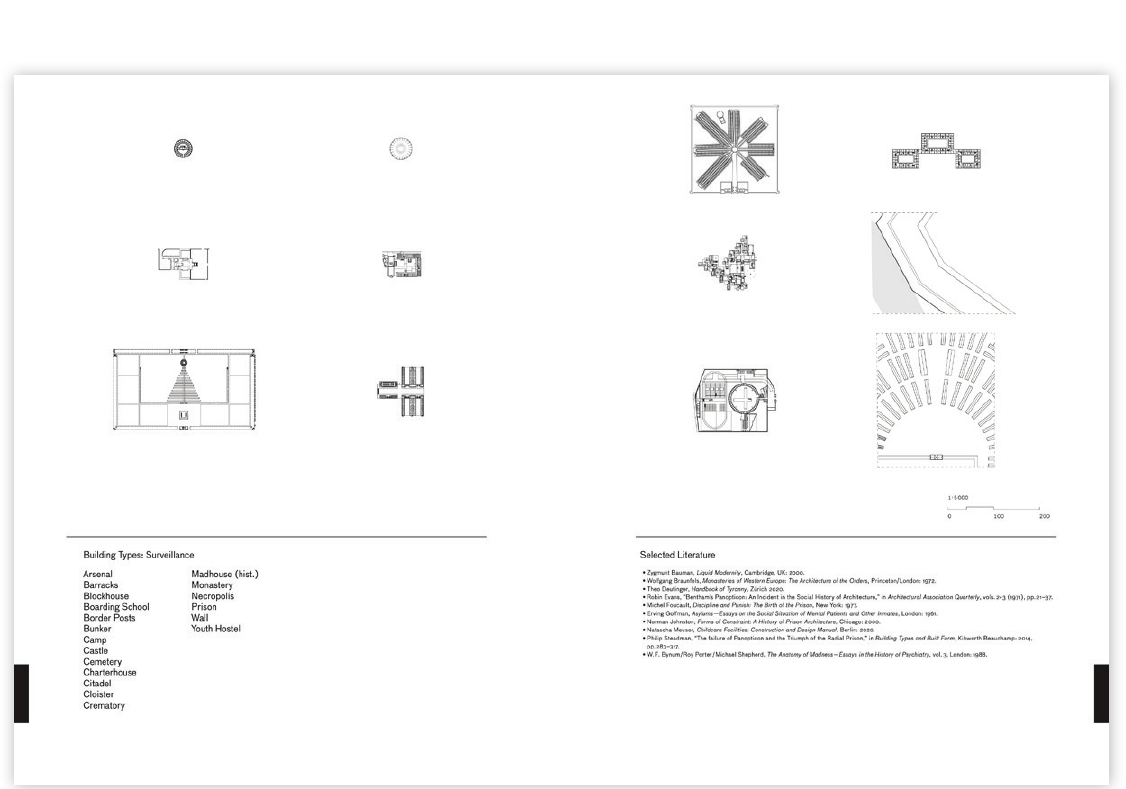
Figure 1. Front cover of Th inking Design: Blueprint for an Architecture of Typology .